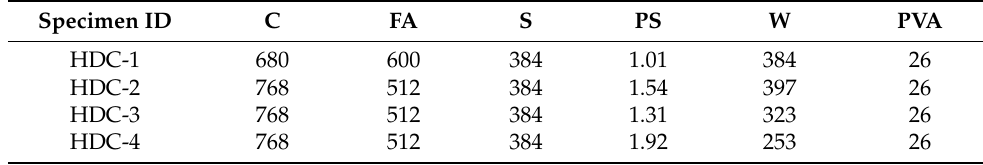
Table 1. Mix proportion of HDC (kg/m 3